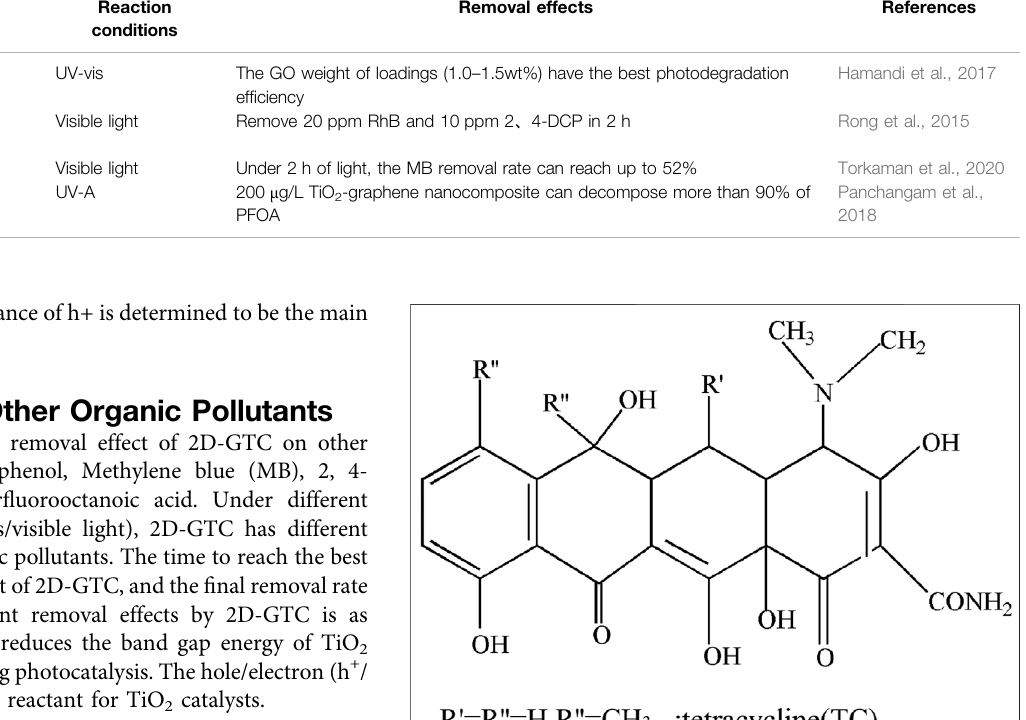
Figure 6 details the reaction of TiO